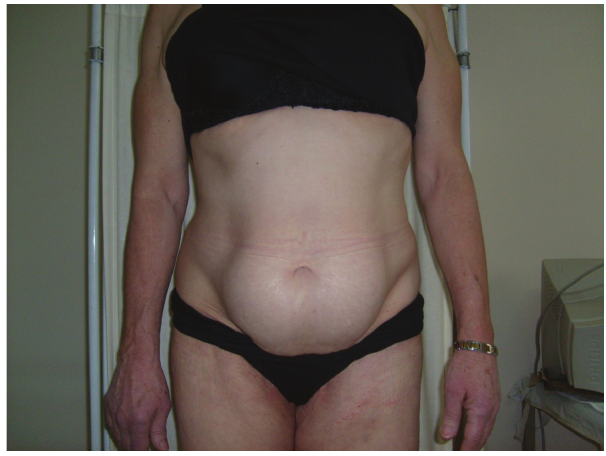
Figure 1 - Areas of lipohypertrophy on the anterior abdominal wall.